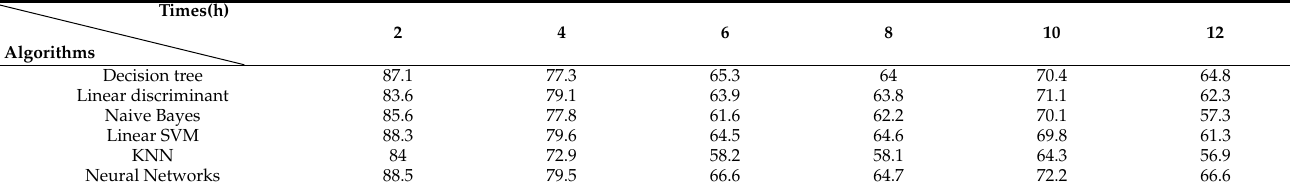
Table 4. Accuracy of the six classification algorithms with